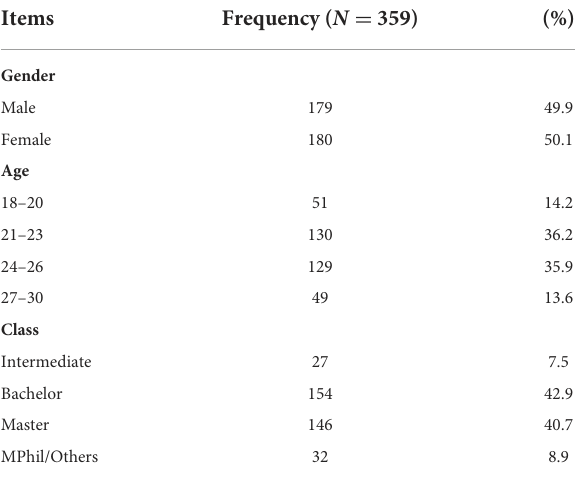
TABLE 1 Demographic